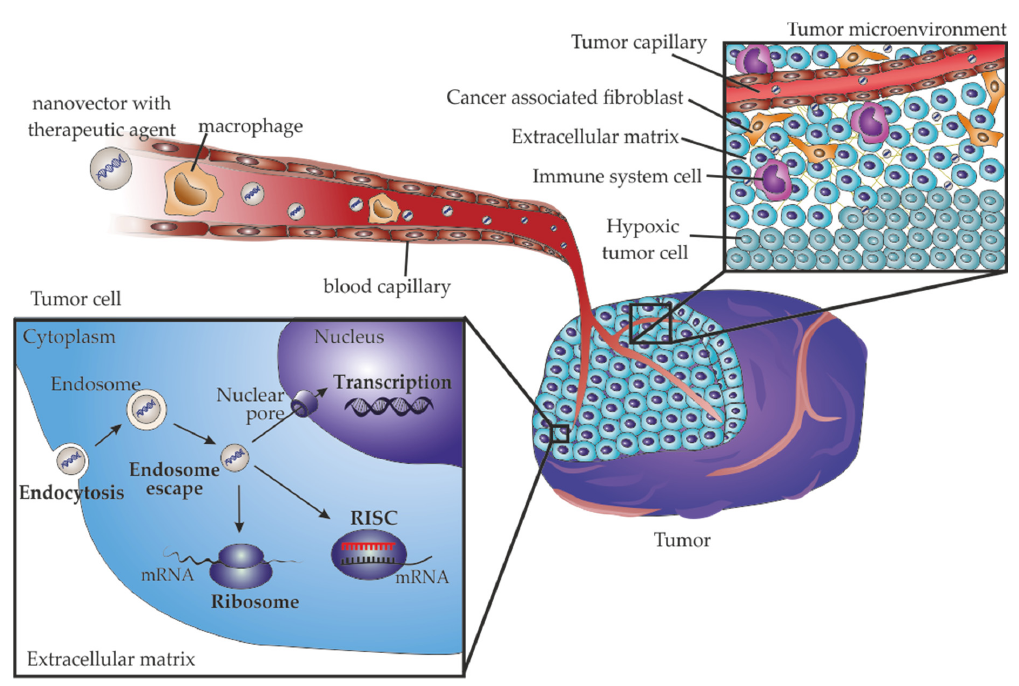
or travel to the nucleus, when targeting